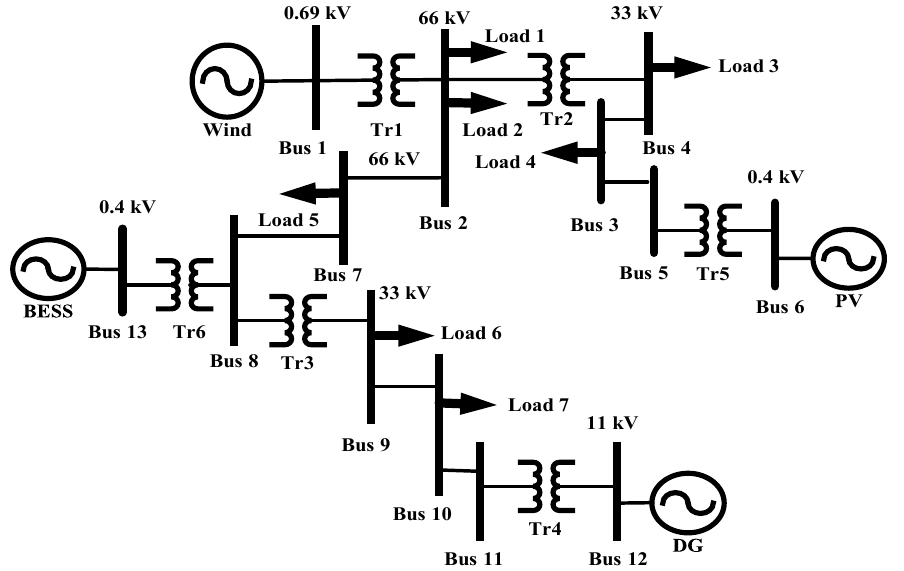
Figure 4. Single line diagram of simplified Kangaroo islanded hybrid microgrid.